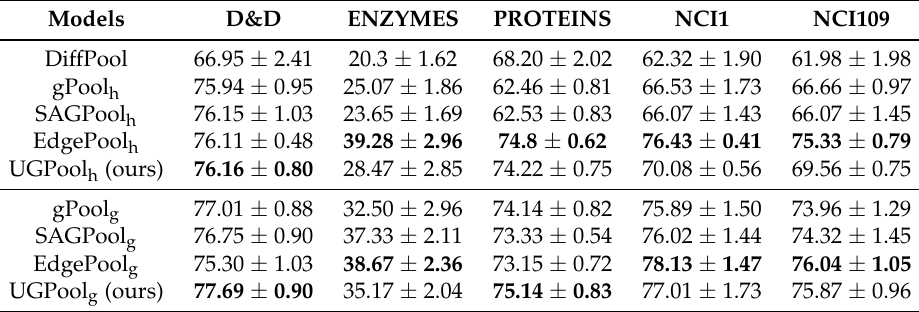
Table 3. Graph classification accuracy via GCNConv with different pooling